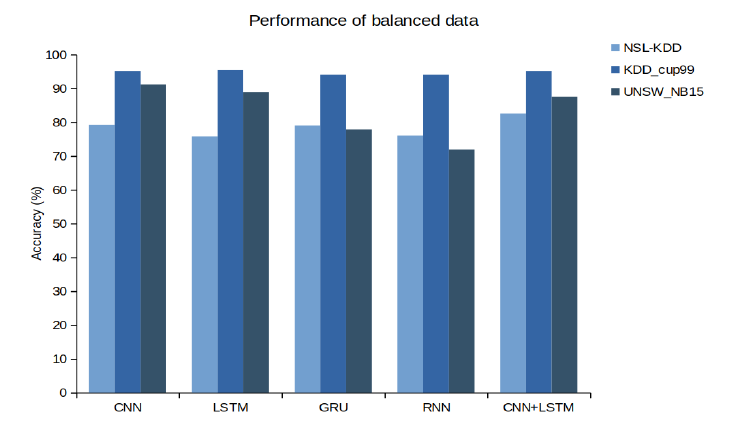
Figure 7. Results of all models using balanced